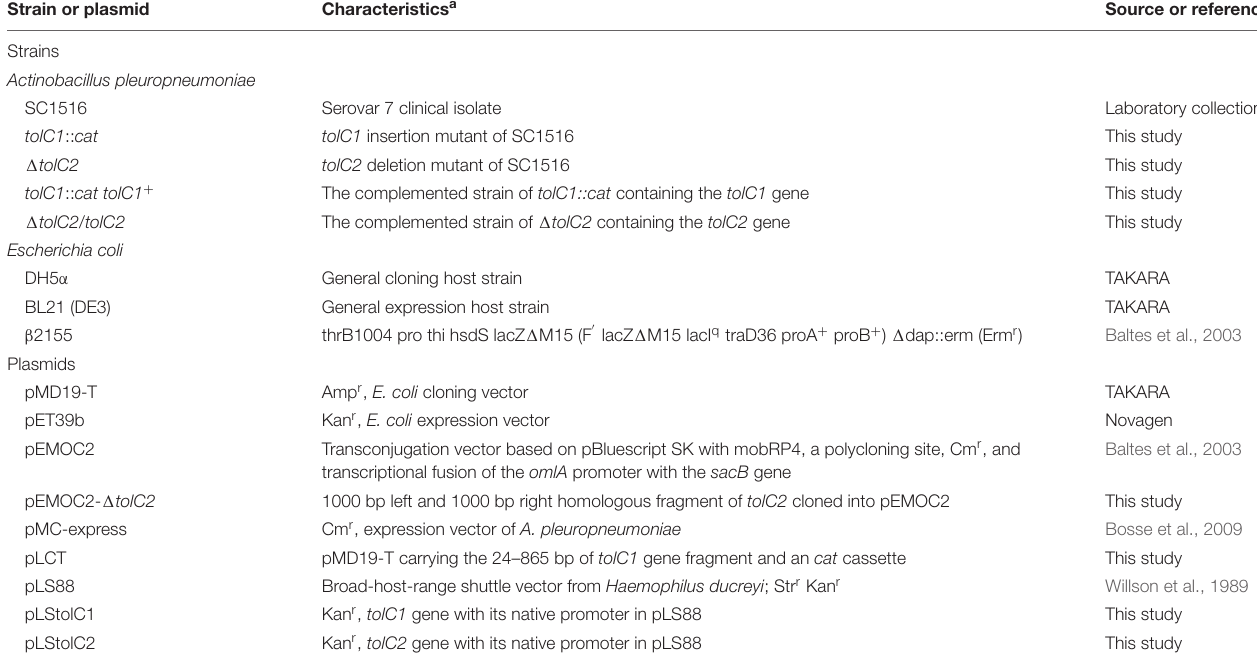
TABLE 1 | Bacterial strains and plasmids used in this study.